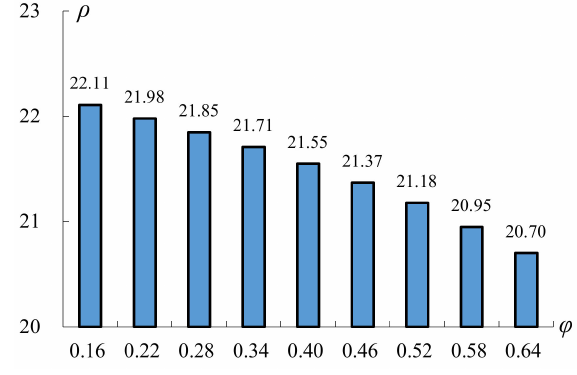
Figure 3. E ff ect of ϕ on ρ .